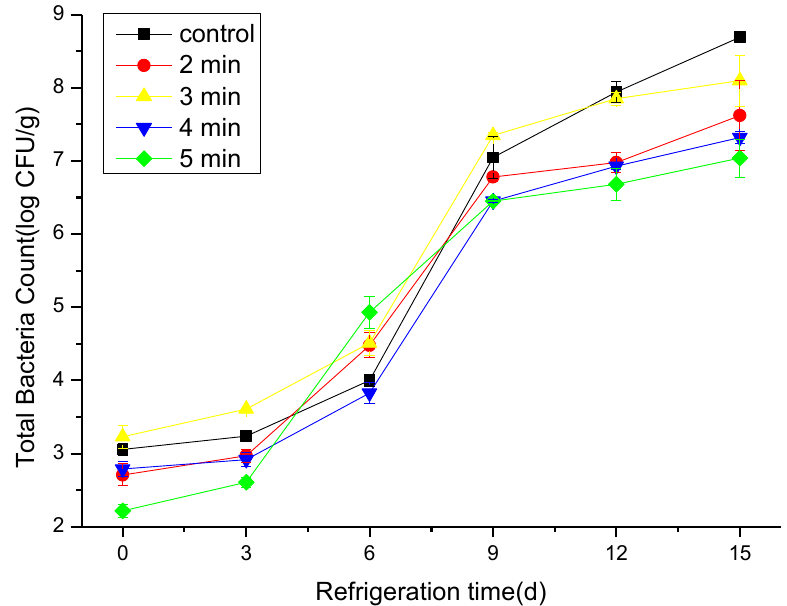
Figure 1. Changes in total bacteria count (TBC) populations in cold stored hairtail fish exposed to CAP at 50 kV voltage for various treatment times: 2, 3, 4, and 5 min. The non-treated sample is included as a control.